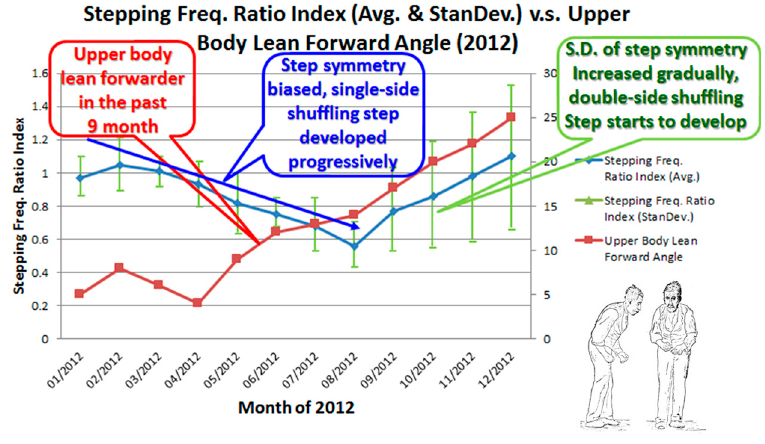
Figure 5. Long-term festination tracking for patients with Parkinson’s disease.